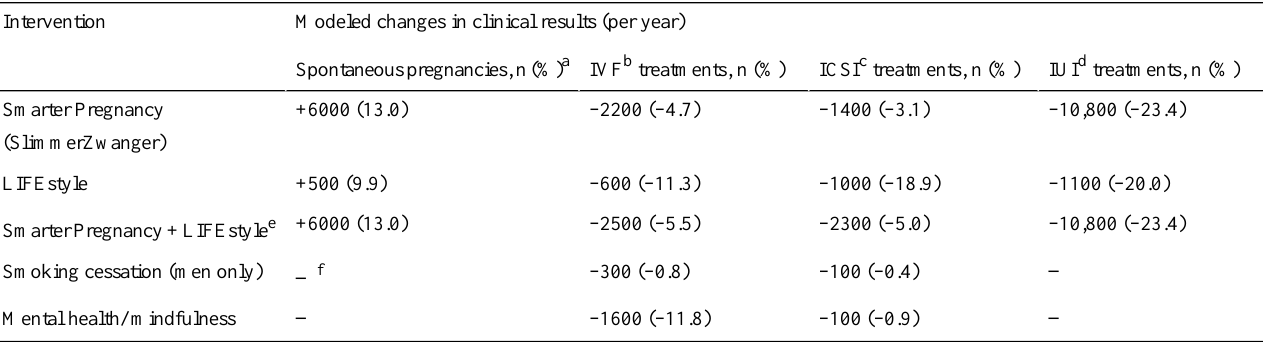
Table 2. The effect of each lifestyle intervention on assisted reproductive technology clinical outcomes modeled for the Netherlands. Modeled changes in clinical results (per year)Intervention